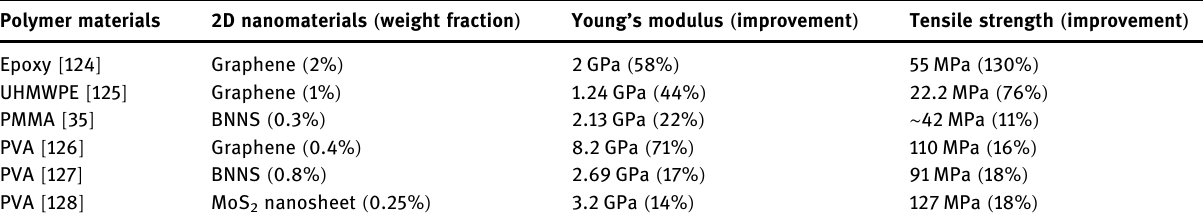
Table 3: Mechanical improvement of polymer materials reinforced by typical 2D nanomaterials Polymer